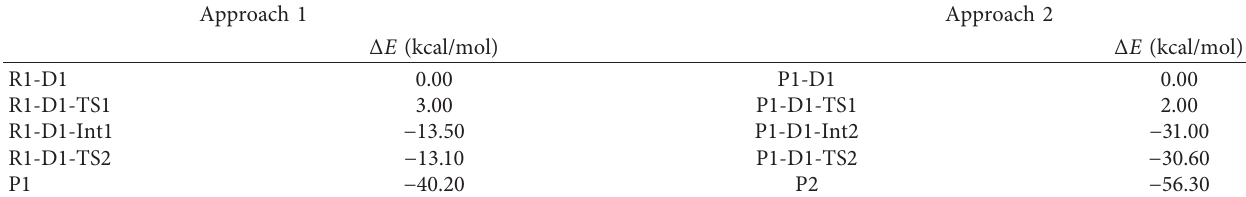
Table 2: Relative energies a ( Δ E ) for DC reactions of reagents R 1 and dipole D1 at B3LYP/6-31G(d).